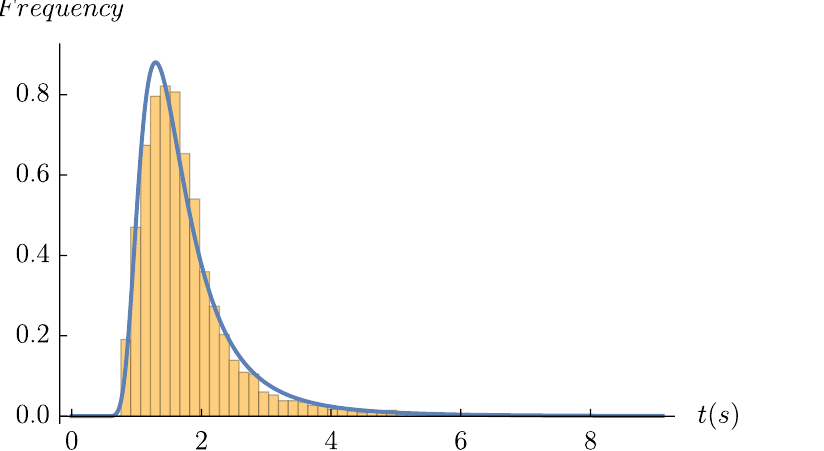
Figure 2 . Histogram of timings for (cid:12)nding solutions for 7559 sets of solutions to the 4D scattering equations at 6 pts NMHV using NSolveScatteringEquations4D . The blue curve is FrechetDistribution[3.7,1.6,-0.2] , as a best (cid:12)t by Mathematica